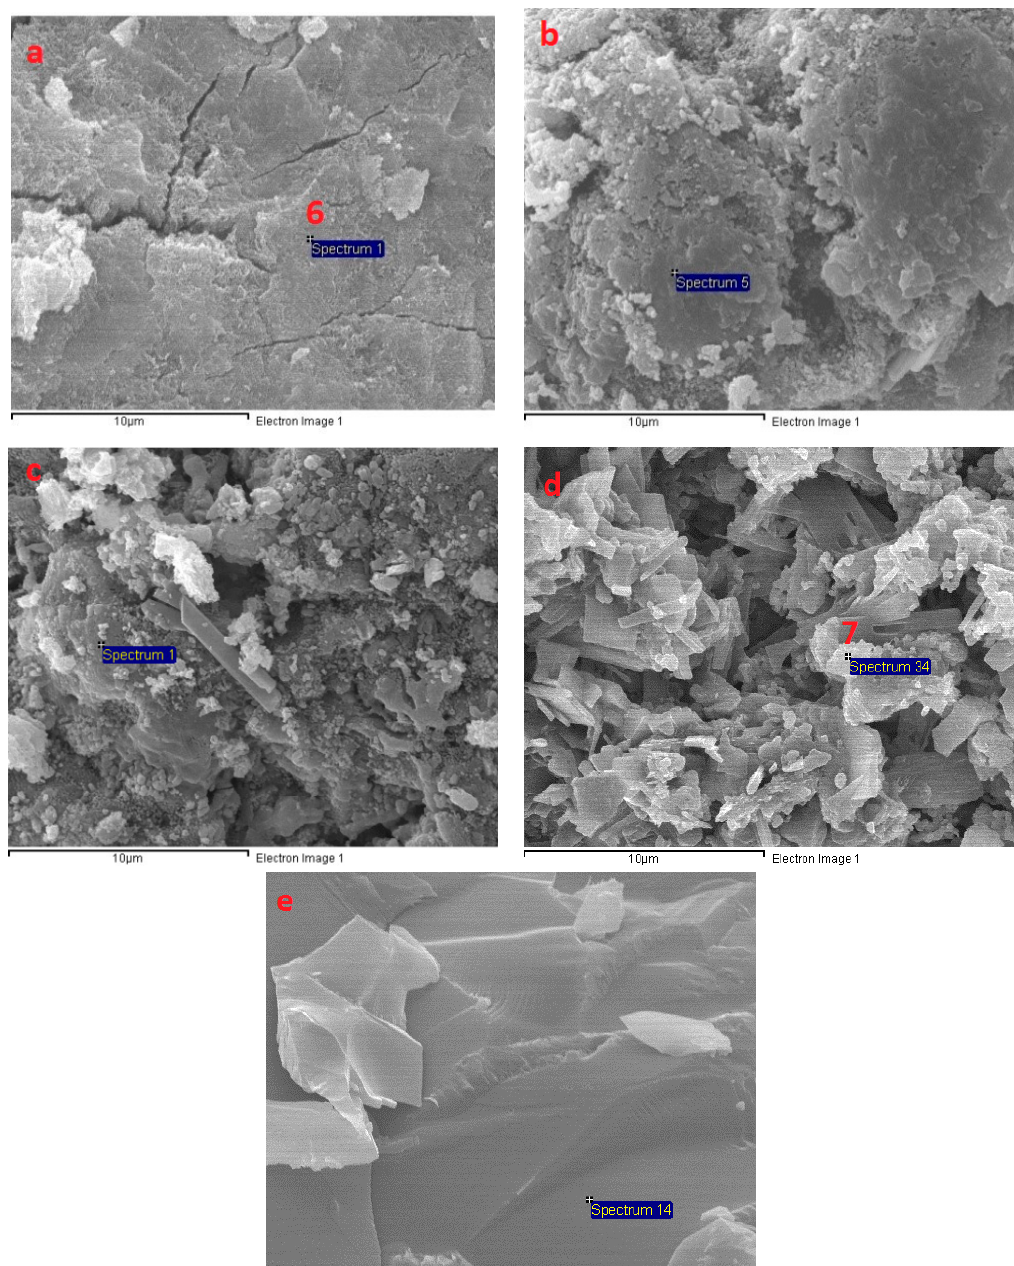
Figure 13. SEM micrographs of fracture surface of A4 at different temperatures: ( a ) 200 ° C ; ( b ) 600 ° C ; ( c ) 800 ° C ; ( d ) 1000 ° C ; and, ( e ) 1200 ° C .